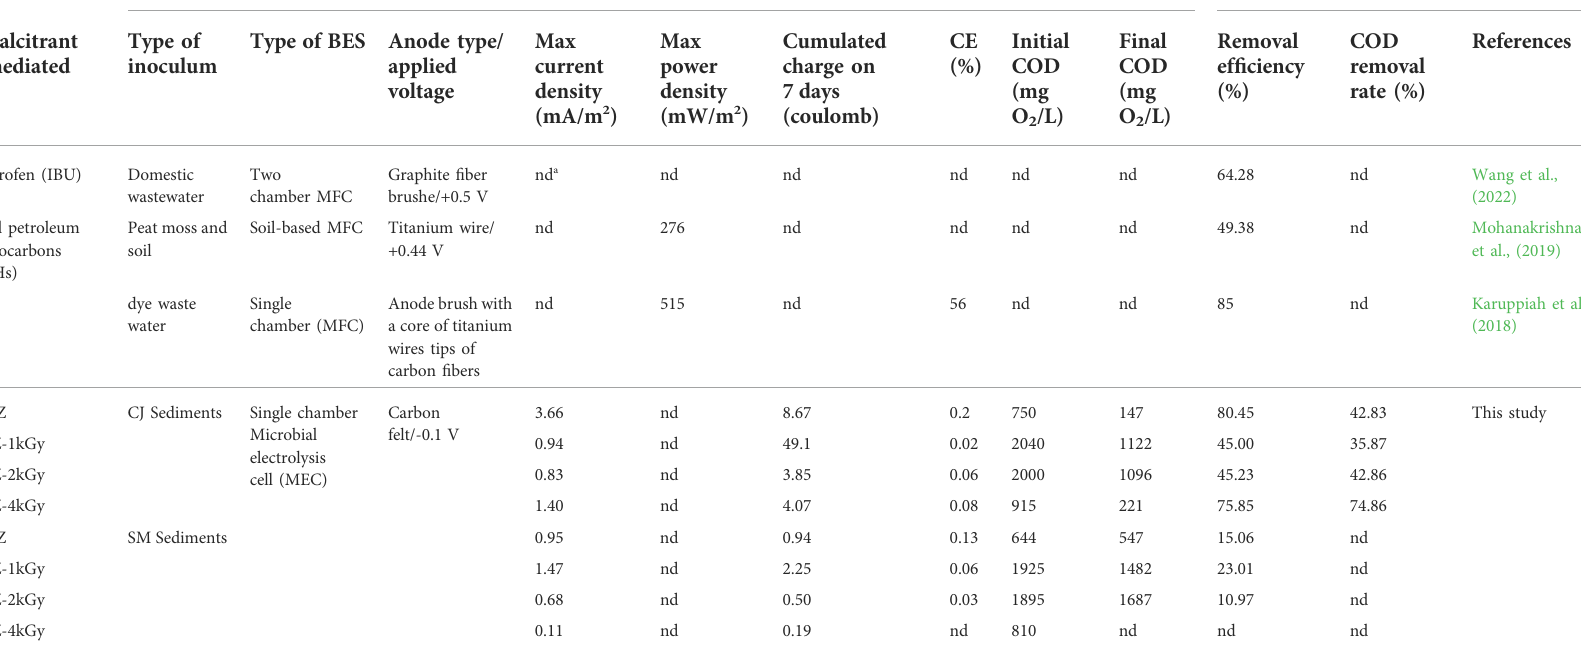
TABLE1Comparativetableofbioelectrochemichalapproaches(voltage,powerdensity,Coulombicef fi ciency,removalef fi ciency)fordifferentrecalcitrantpollutantsremediation.ChottElDjerid(CJ)and Sebkhet El Melah (SM) sediments performances were measured under identical conditions for both bioelectrochemical and biological